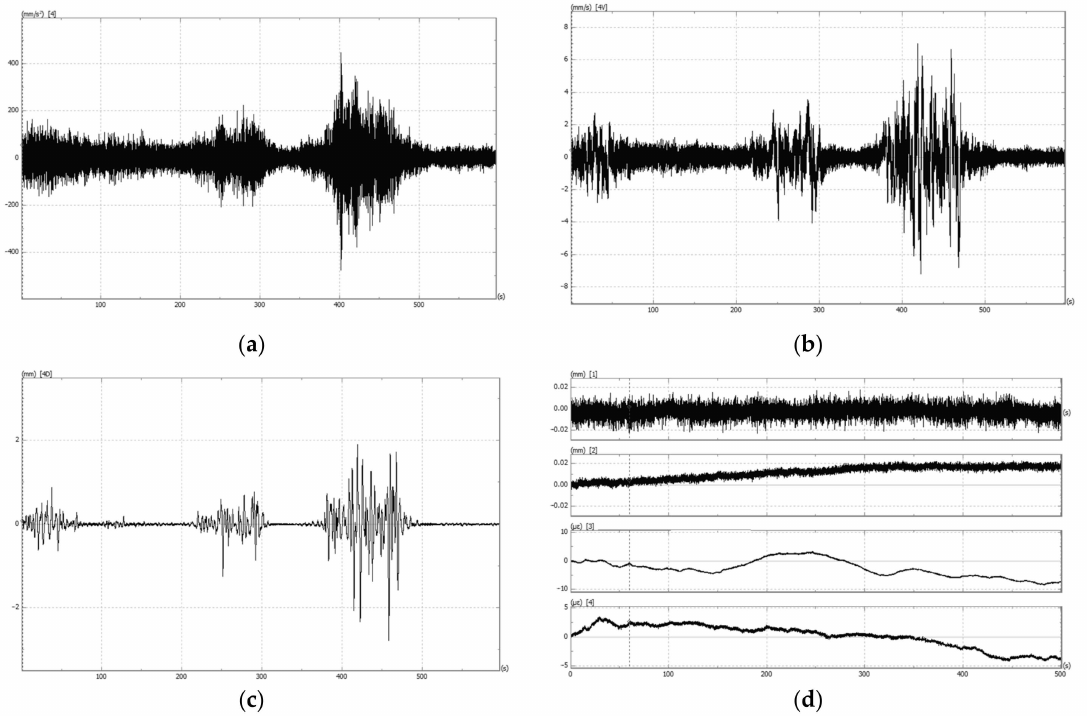
Figure 3. Test results: ( a ) horizontal acceleration time curve at column D; ( b ) horizontal velocity time-course curve at column D; ( c ) horizontal displacement time curve at column D; ( d ) A, D column displacement and strain testing. (From top to bottom, they are column A displacement, column A strain, column D displacement, and column D